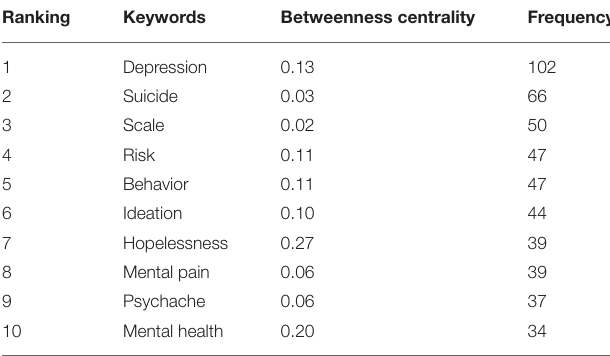
TABLE 2 | The top 10 keywords in terms of frequency for psychache in the suicidology